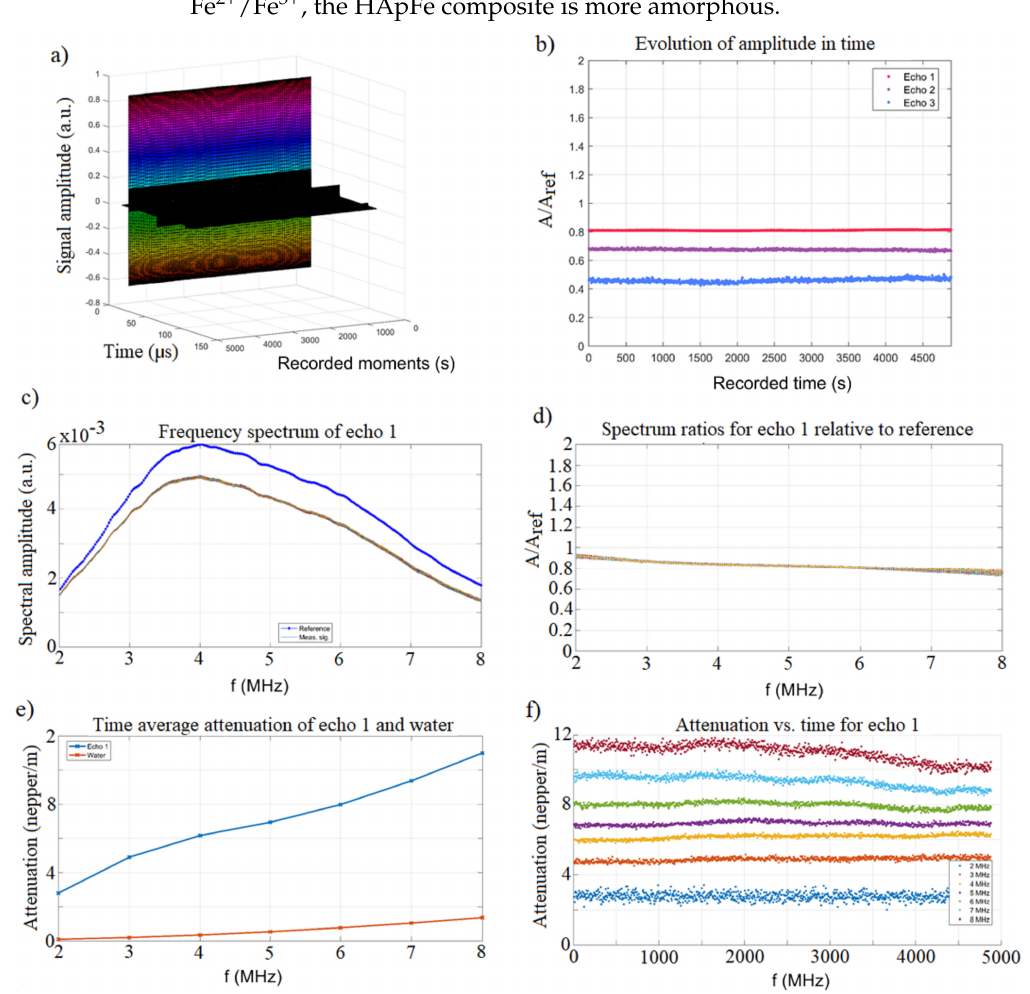
Figure 2. ( a ) Recorded signals at 5 s recording interval. The constant peak amplitudes of the first echo are shown in color, whereas the second and third echo are significantly weaker (shown in black). ( b ) Relative amplitudes of evolution vs. the recording moments. ( c ) Frequency spectrum of the first transmitted echo. Reference fluid ( (cid:7) ). ( d ) Relative spectral amplitude (A/Aref) vs. frequency. ( e ) Attenuation vs. frequency for the first transmitted echo. ( f ) Attenuation vs. time for the spectral components of the first echo.